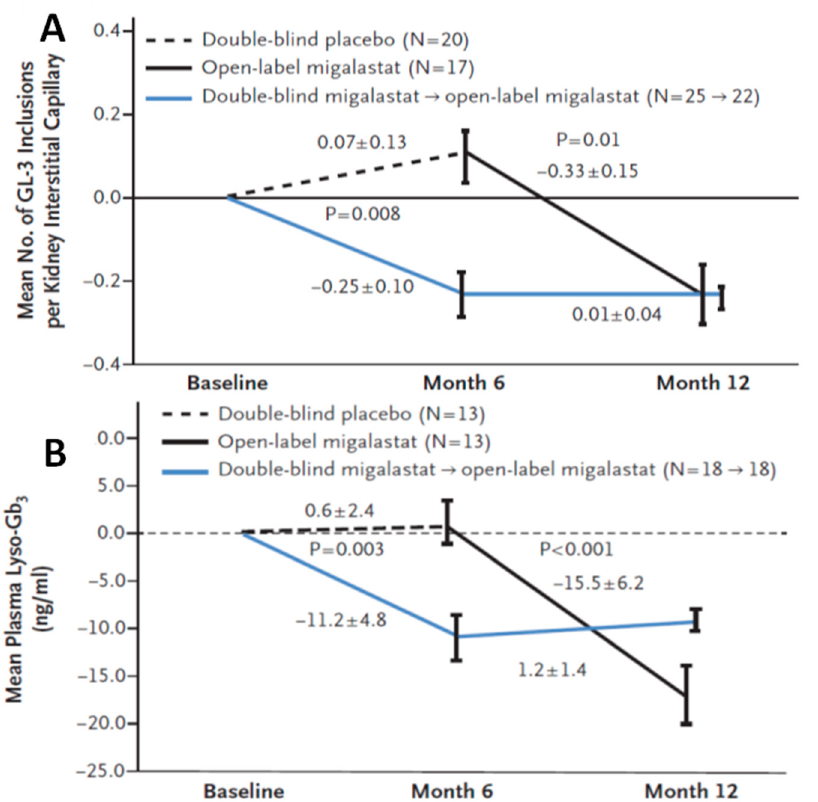
Figure 2. ( A ) Difference from baseline in kidney interstitial capillary globotriaosylceramide (GL-3) in patients with mutant α -galactosidase forms that were suitable for Migalastat treatment [31]. An analysis of covariance (ANCOVA) model with covariate adjustment for baseline value and factors for therapy group and therapy-by-baseline interaction was used for the difference from baseline to month six, the p value of 0.008 corresponds to the least-squares mean differences between Migalastat and placebo. A mixed effects model for repeated measures was used for the difference from month 6 to month 12 in patients switching from placebo to Migalastat. The model used fixed effects for therapy group and time, time-by-therapy interaction, and baseline GL-3 inclusion. I bars indicate standard errors (SEM) [31]. ( B ) Change from baseline in plasma globotriaosylsphingosine (lyso- Gb3) levels in patients with suitable mutant α -galactosidase. Baseline values were normalized to zero, and data represent the mean difference from baseline of month six. An ANCOVA model was used to compare Migalastat with placebo from baseline to month six and to compare the difference from six to month 12 in patients changing from placebo to Migalastat. The ANCOVA model used covariate adjustment for baseline value and factors for therapy group and therapy-by-baseline interaction. p values correspond to the least-squares mean difference between Migalastat and placebo. Of the 44 patients who allowed plasma lyso-Gb3 analyses, 31 had suitable mutant α - galactosidase. I bars indicate standard errors (SEM) [31]. ( A , B ) adapted from Germain et al., with permission [31].